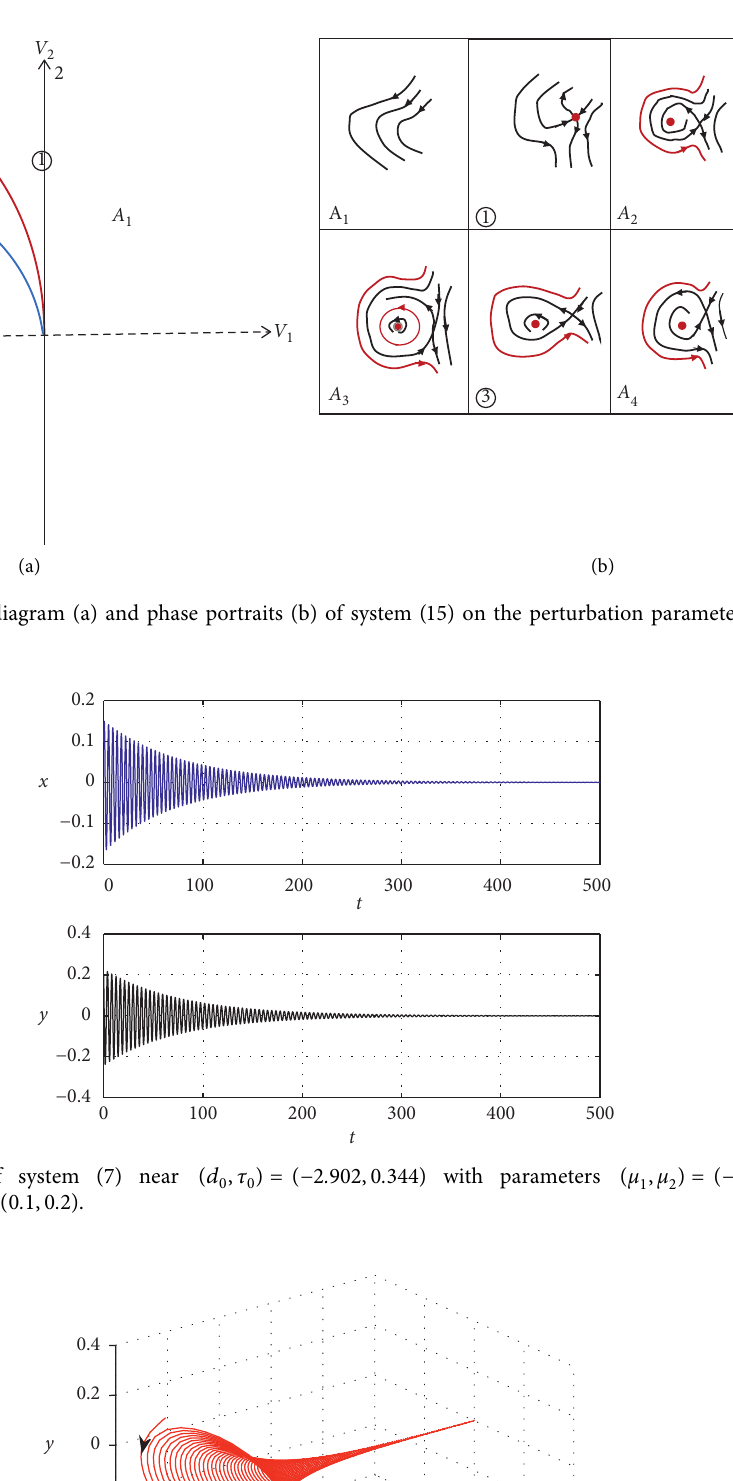
, τ ) � (− 2 . 902 , 0 . 344 ) with parameters ( μ 0 0